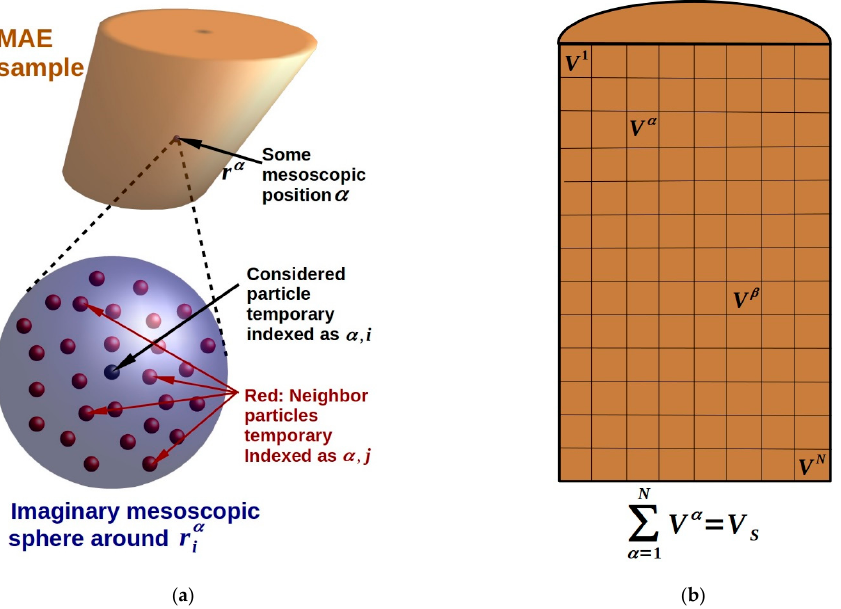
Figure 11. ( a ) Sketch of the decomposition of an MAE sample into short- and long-range effects; ( b ) Formal discretization of sample volume V s into mesoscopic portions V α , α ∈ [ 1, N ] . On such scales any particle microstructure appears a homogeneous continuous distribution [153].